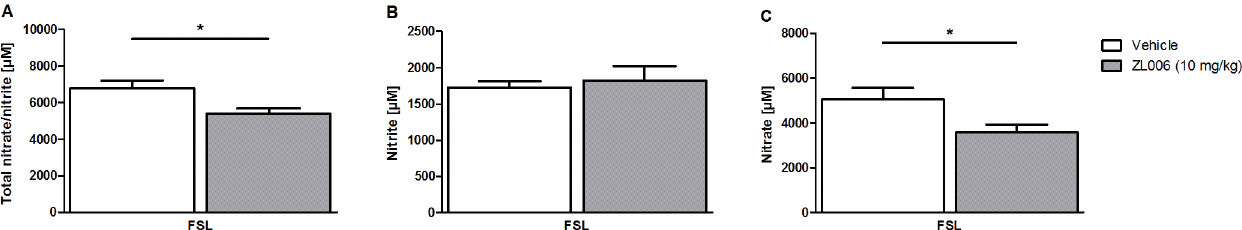
Fig 6. Cerebellar nitrate/nitrite measurements after repeated ZL006 (10 mg/kg) injections (24 h, 19 h, and 1 h prior to decapitation) in Flinders Sensitive Line rats. A : Total nitrate/nitrite concentrations were decreasedin rats treated with ZL006 comparedto vehicle, * : p (cid:20) .05. B : Nitrite concentrations were unchangedbetweentreatment groups, p > .05. C : Nitrate concentrations ([total nitrate/nitrite]–nitrite) were decreased in ZL006-treated rats, * : p (cid:20) .05; n = 8/group. Values representmeans ± SEM and were analyzedusing one-wayANOVAs.